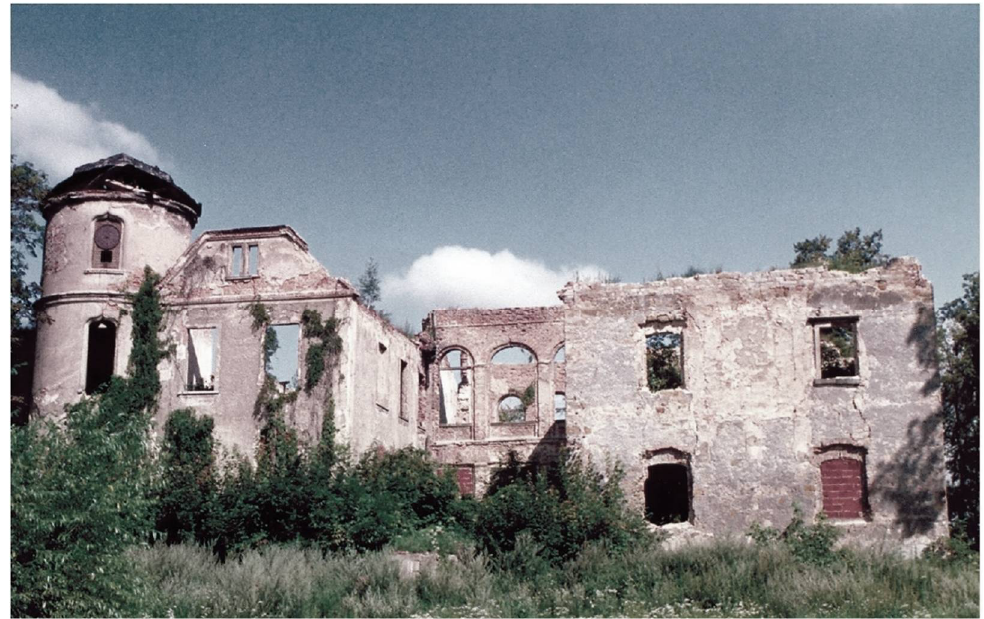
Figure 35. This Renaissance, single-body mansion in Zagrodno was expanded in the eighteenth century; its current condition is the result of building degradation that took place after 1945. Decorative sgraffiti were removed from the wall gable, the lower part of which is visible is on the right side of the photo. Author’s photo, 2003.